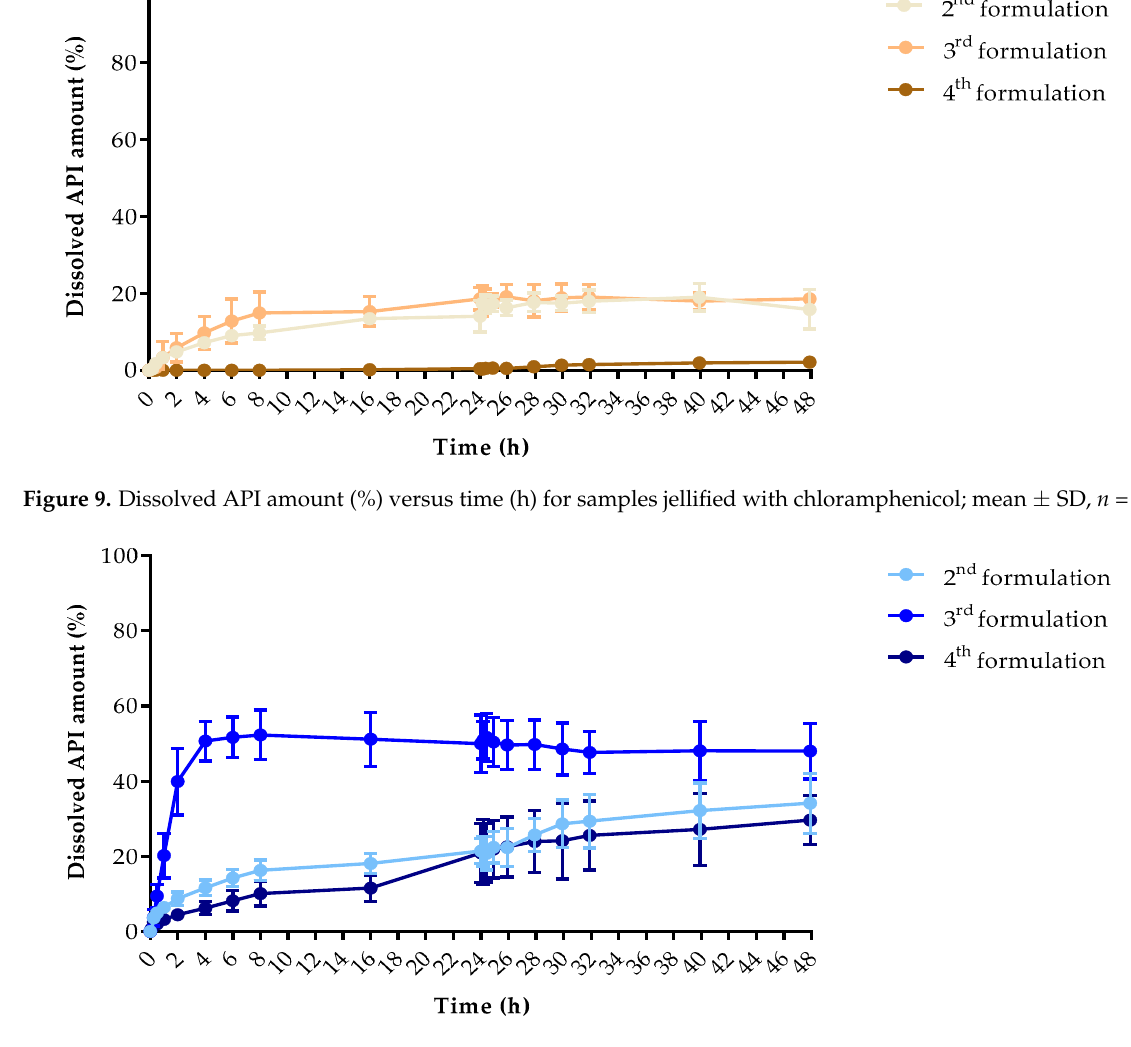
Figure 10. Dissolved API amount (%) versus time (h) for samples jellified with metronidazole; mean ± SD, n = 4. Table 6. The kinetic analysis of the dissolved samples. Drug release data were fitted to zero-order and first-order kinetic models for 0-48 h, 0-8 h, and 8-48